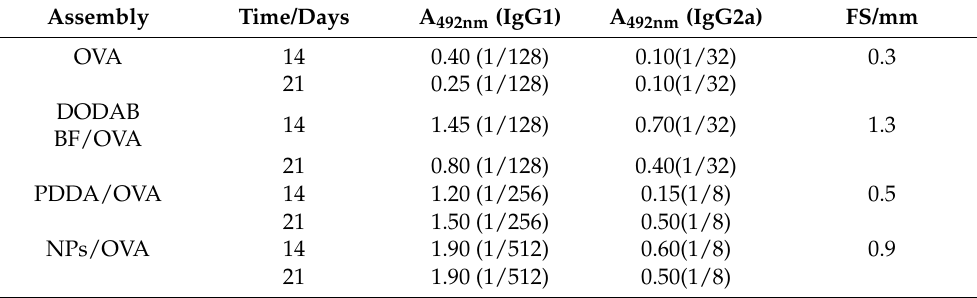
Table 3. Comparison of IgG1 and IgG2a production and footpad swelling (FS) induced by the